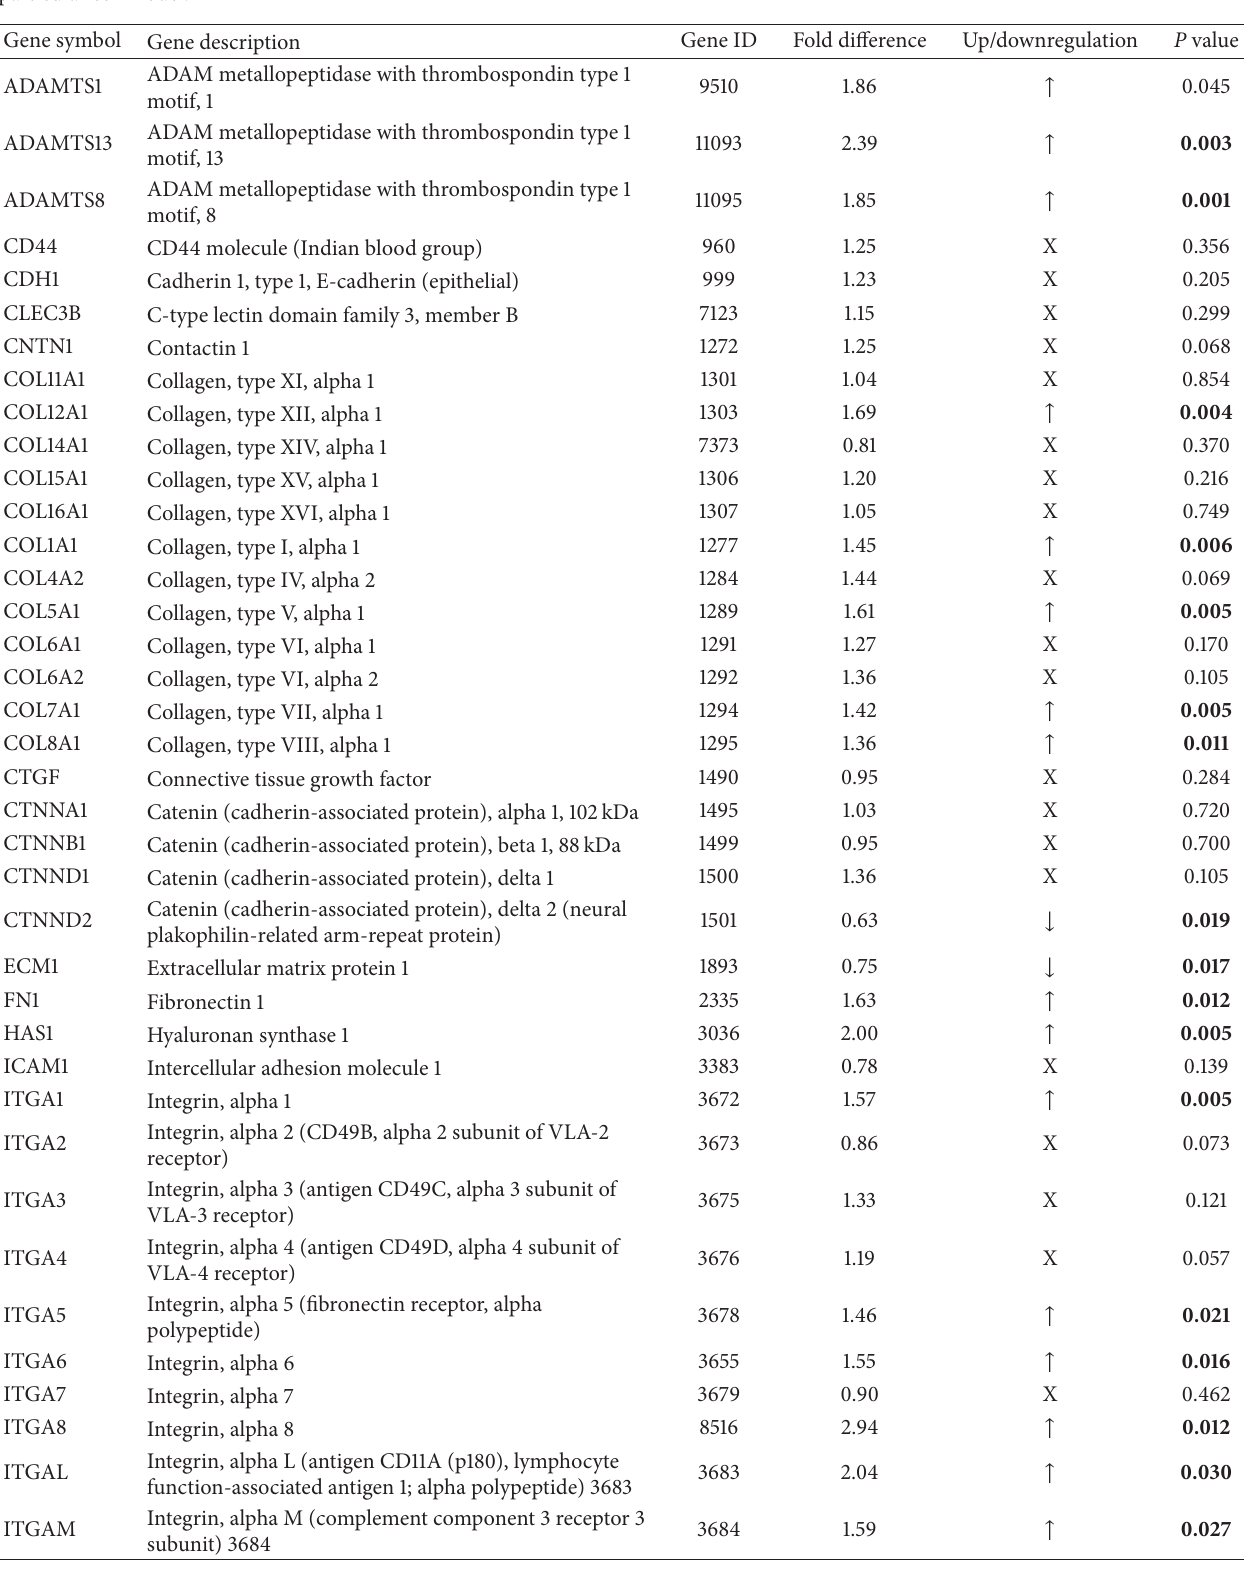
Table 4: Gene expression profile in normal wounded (NW) cells irradiated at 660 nm. Total RNA from nonirradiated N cells and irradiated NW cells were characterised in triplicate. A fold difference > 1 is considered as gene upregulation, while a fold difference < 1 is considered as gene downregulation. Fold differences are indicated as upregulation ( ↑ ) or downregulation ( ↓ ). X denotes the nonsignificant genes in that particular cell